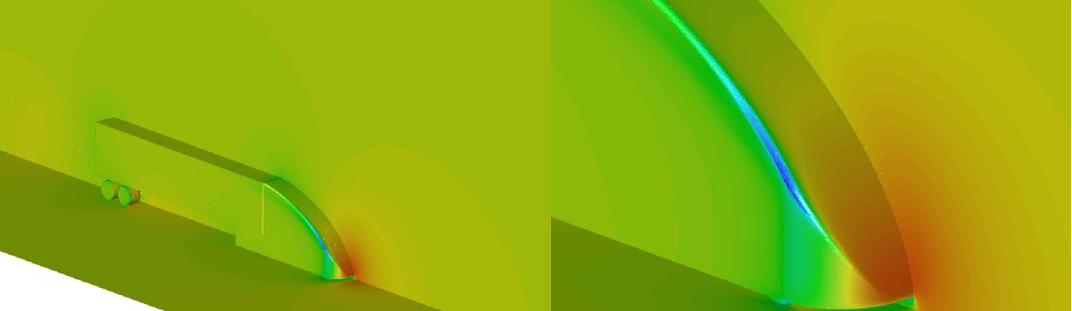
Fig. 11. Flow pressure coefficient over Concept Two (left), and a magnified view of the frontal area